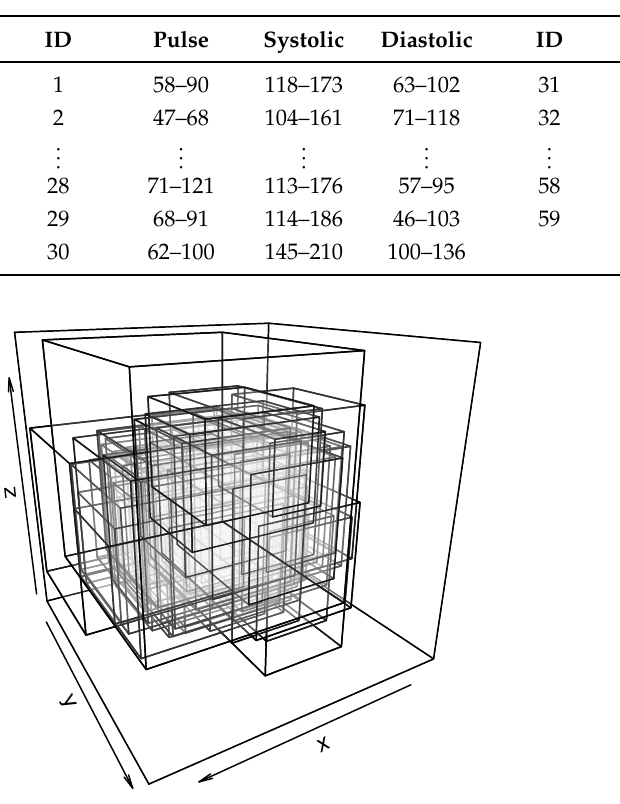
Table 1. Cardiology three-dimensional cuboid dataset for some patients. Columns 2 and 6, named Pulse, contain the range of blood pulse over a day for each patient, labelled by an identification number (ID) in columns 1 and 5. Columns 3 and 7, named Systolic, provide the range of systolic blood pressure over the same day per patient. Columns 4 and 8, named Diastolic, display the range of diastolic blood pressure over the same day per patient.